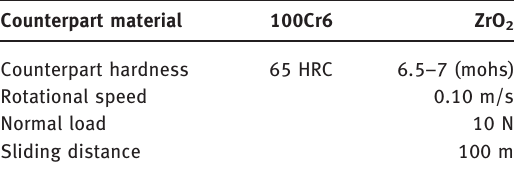
Table 3: Parameters used in wear